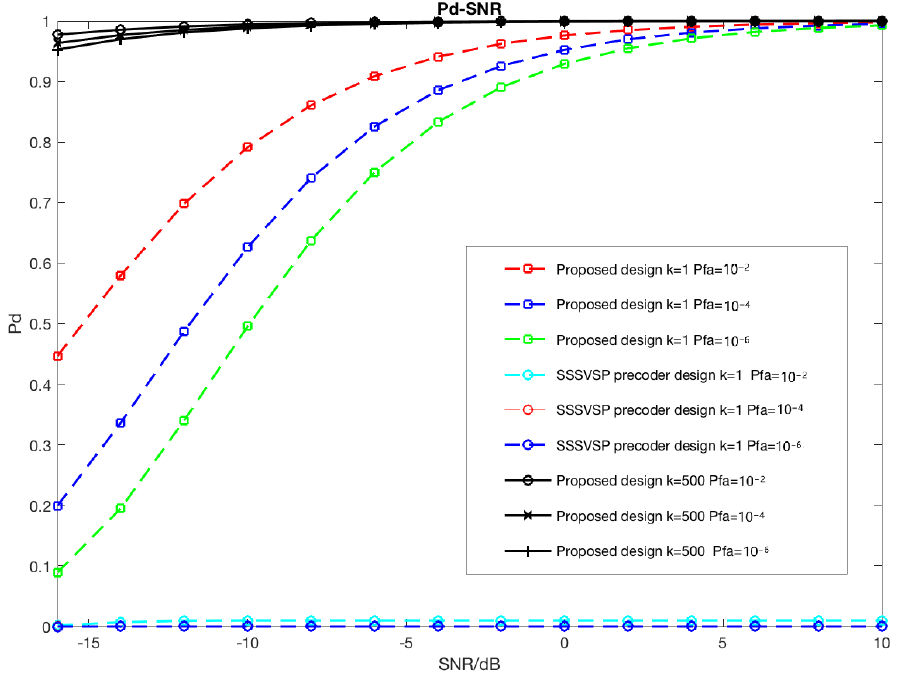
Figure 5. Detection performance difference comparison between proposed max-SINR joint precoder– decoder design and SSSVSP at P fa = 10 − 2 , P fa = 10 − 4 , and P fa = 10 − 6 . A single pulse k = 1 and multi-pulse k = 500 are considered in this